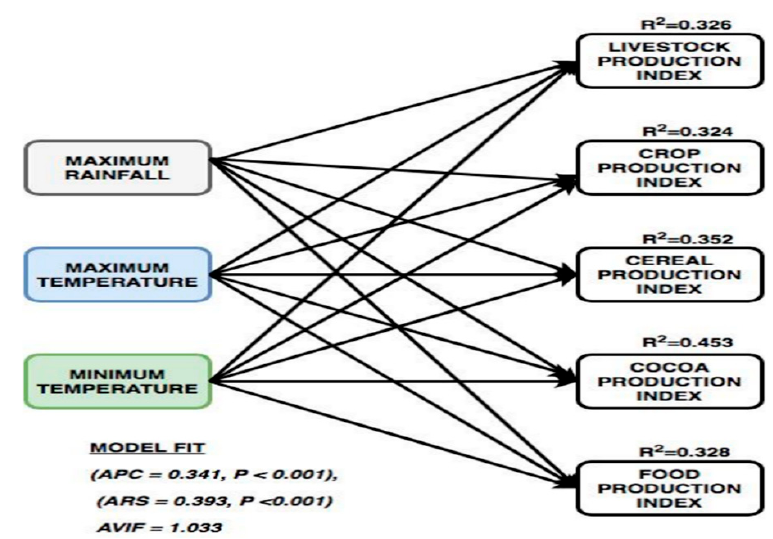
Figure 7. The Conceptual frame of the relationship of extreme weather on agriculture production indexes.